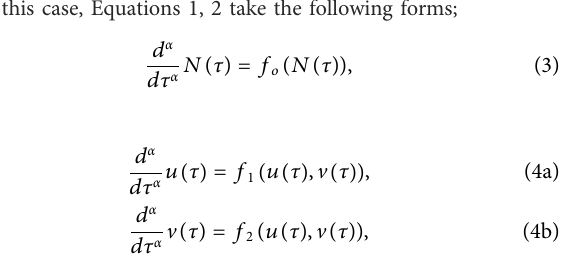
FIGURE 2 The transient population N ( τ ) versus the normalised time τ = γ t (as log scale), for control parameter with positive perturbation, K = K c + β ; K c =3.6631 at the switching-on point, A on , of Figure 1 and fi xed β =0.1, and for α =1 (ordinary derivative) and 0.25 (Caputo ’ s and Caputo- Fabrizio ’ s fractional derivatives).